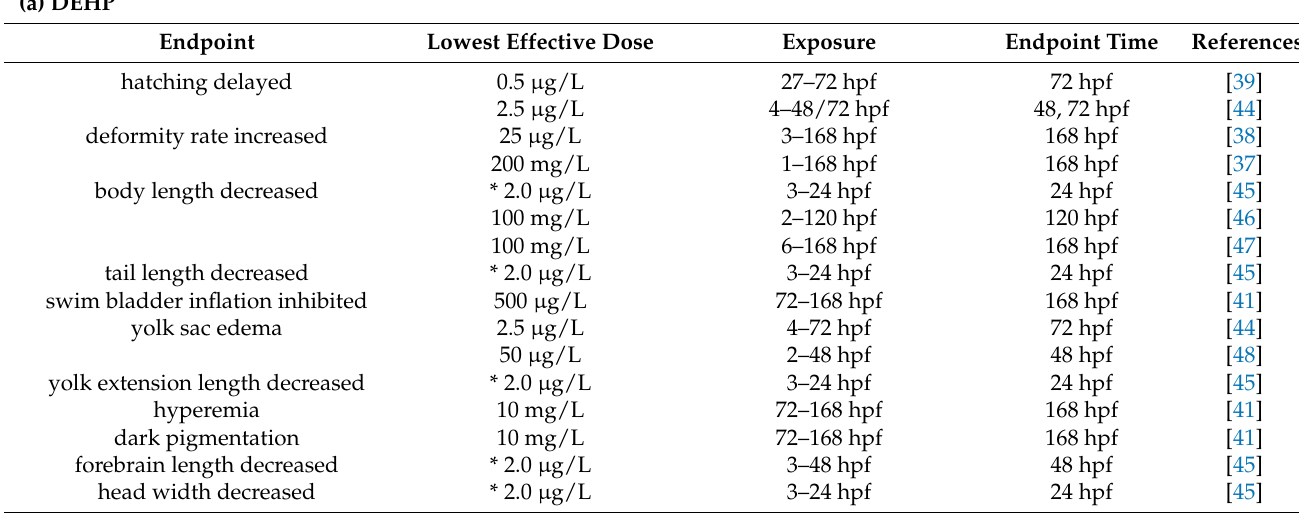
Table 2. Developmental and morphological defects from acute exposures to (a) DEHP and (b) MEHP in zebrafish embryos. * The concentration was converted from nM or µ M using the molar mass of DEHP 390.57 g/mol. ** The concentration was converted from nM or µ M using the molar mass of MEHP 278.34